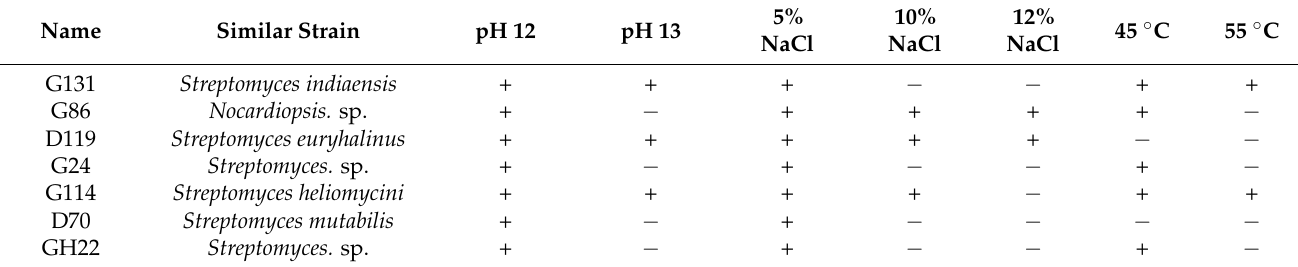
Table 6. Resistance characteristics of partial respective isolates.